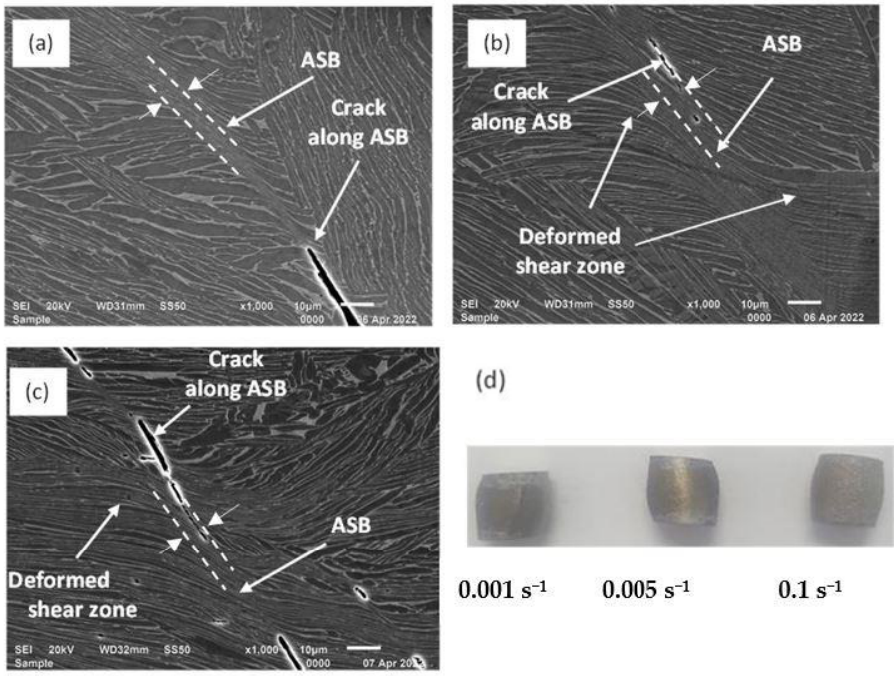
Figure 16. Typical shear-deformed surfaces of samples E after tests at strain rates of ( a ) 0.001 s − 1 , ( b ) 0.005 s − 1 and ( c ) 0.1 s − 1 , while ( d ) shows the typical condition of the test samples after testing at the respective strain